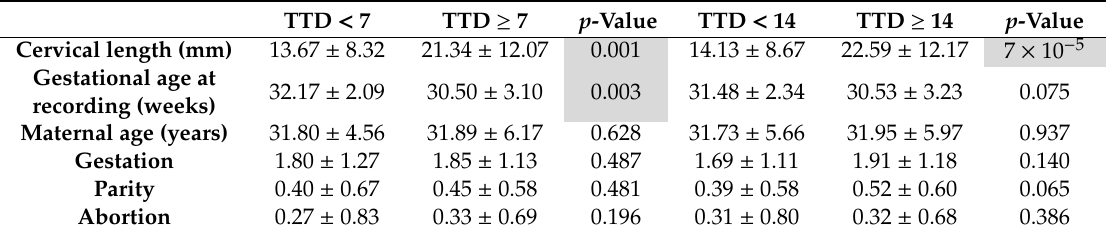
Table 2. Mean and SD of obstetric data of women who delivered in less and more than 7 days and 14 days. p -value < 0.05 (grey shading) indicates significant di ff erences between both groups. TTD < 7 TTD ≥ 7 p -Value TTD < 14 TTD ≥ 14 p -Value Cervical length (mm) 13.67 ±